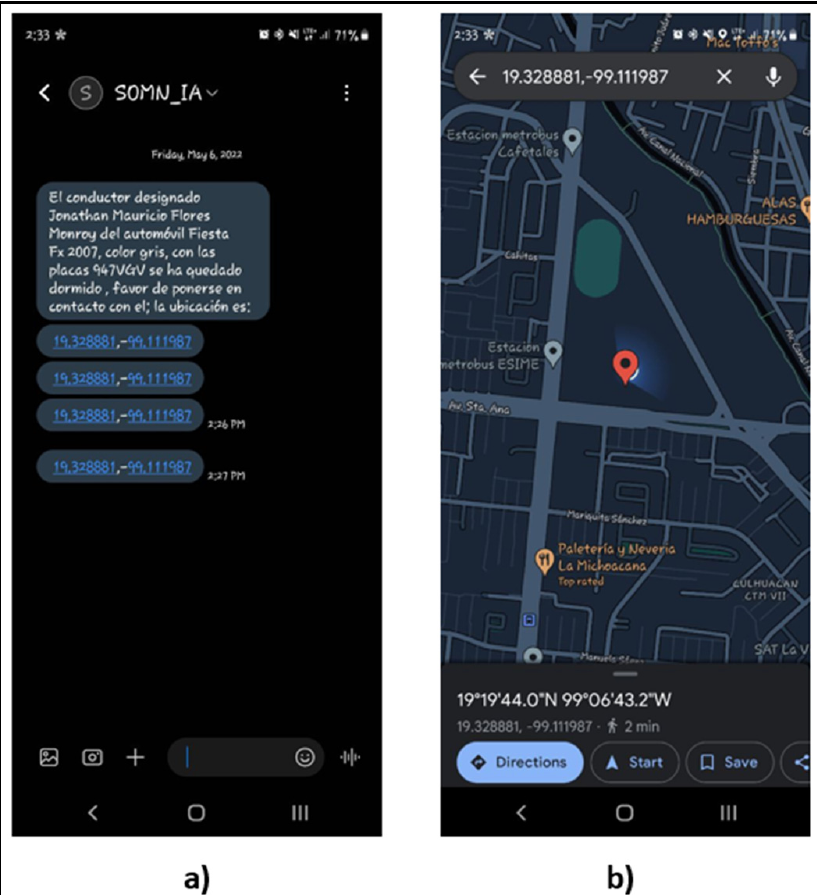
Figure 28. The information transmitted by the TS alarm, in which GSP information is updated in real ‐ time, as shown in ( a ) and in ( b ) the map, indicates the localization of vehicle. The global functionality of the SOMN_IA (supplementary material) can be observed in the following link to a video created by us. https://youtu.be/035Qq5egiS8 (produced on May